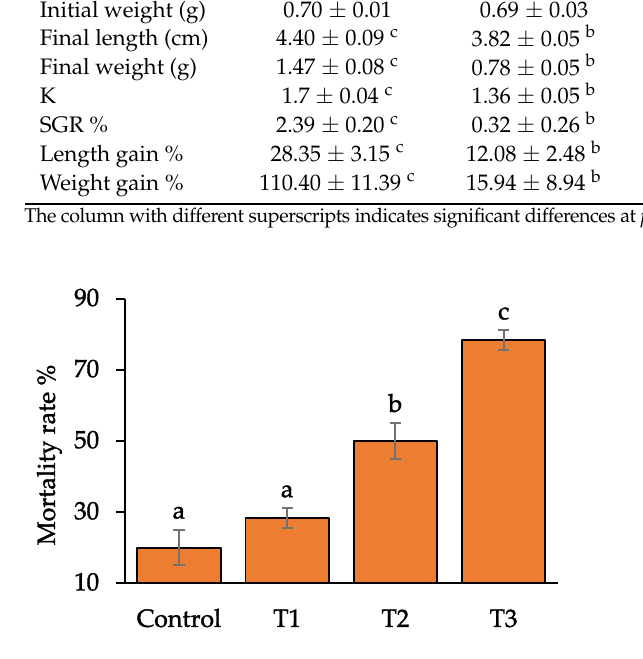
Figure 3. The mortality rate of O. niloticus in different treatment groups. Different superscripts indicate significant differences at p < 0.05.